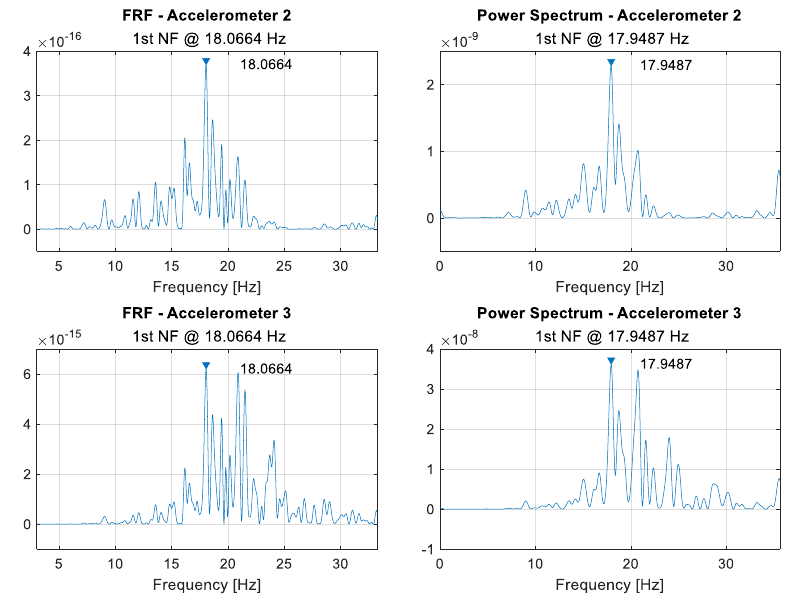
Figure A9. Arduino measurement: 1.0 revolution bolt release.